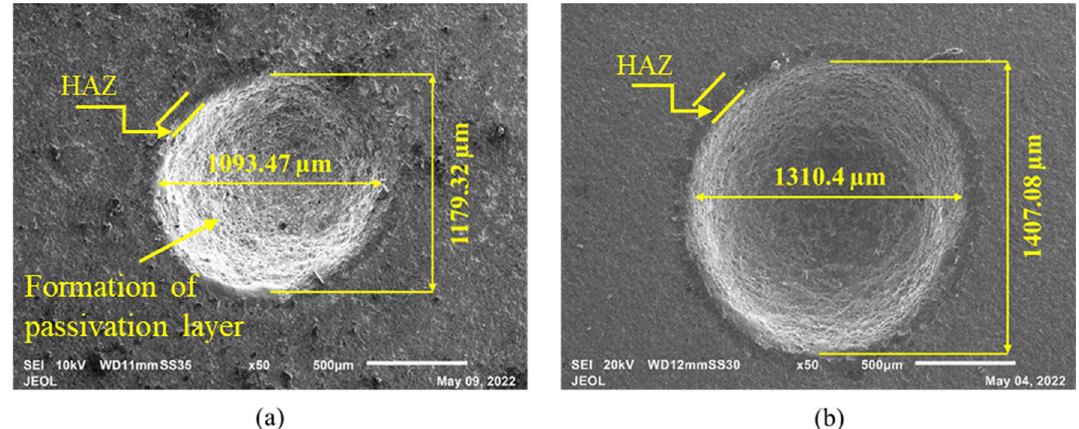
Figure 7. Micrographs of the machined microholes at ( a ) 60 V, 20 wt%, 50% DF and ( b ) 80 V, 20 wt%, 50% DF.